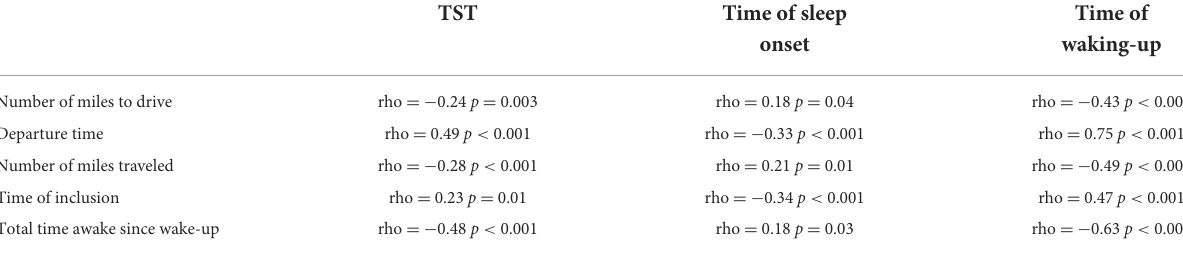
TST Time of sleep